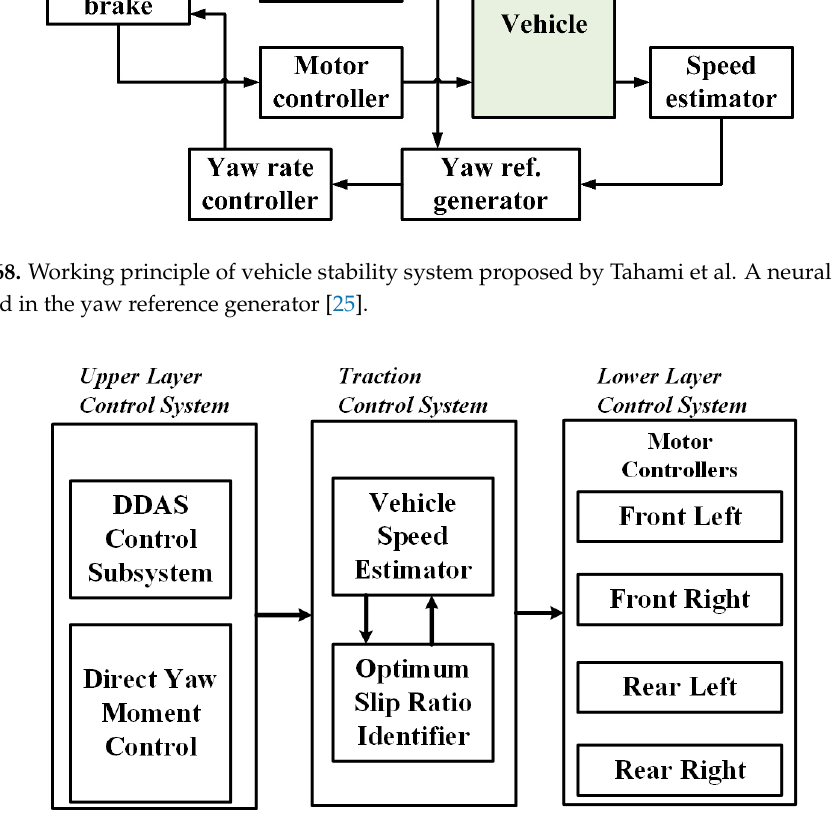
Figure 71. Transition of the operating modes of the vehicle used in [181] by Hui et al. From engine start to shutdown through stops, the vehicle can use either the hydraulic or the electric system, or it can use both.